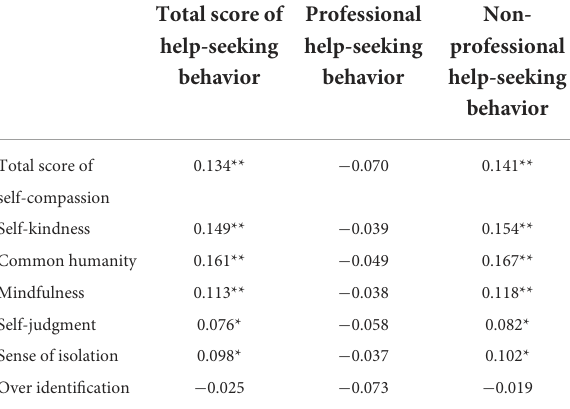
TABLE 8 Correlation between self-compassion and help-seeking